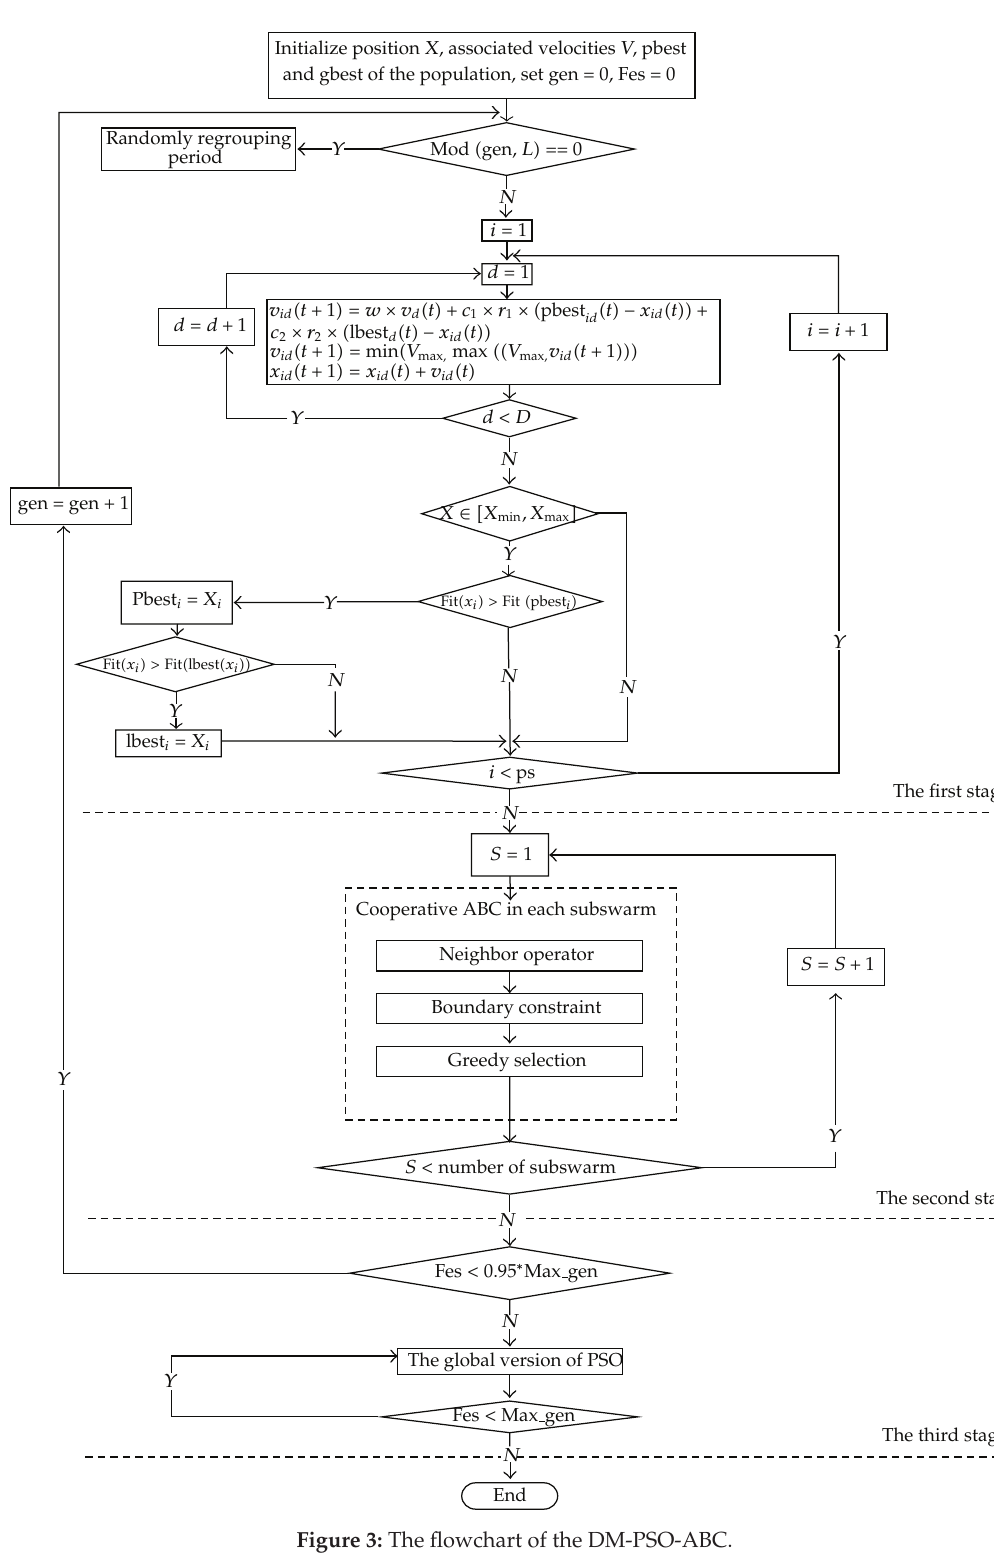
Figure 3: The flowchart of the